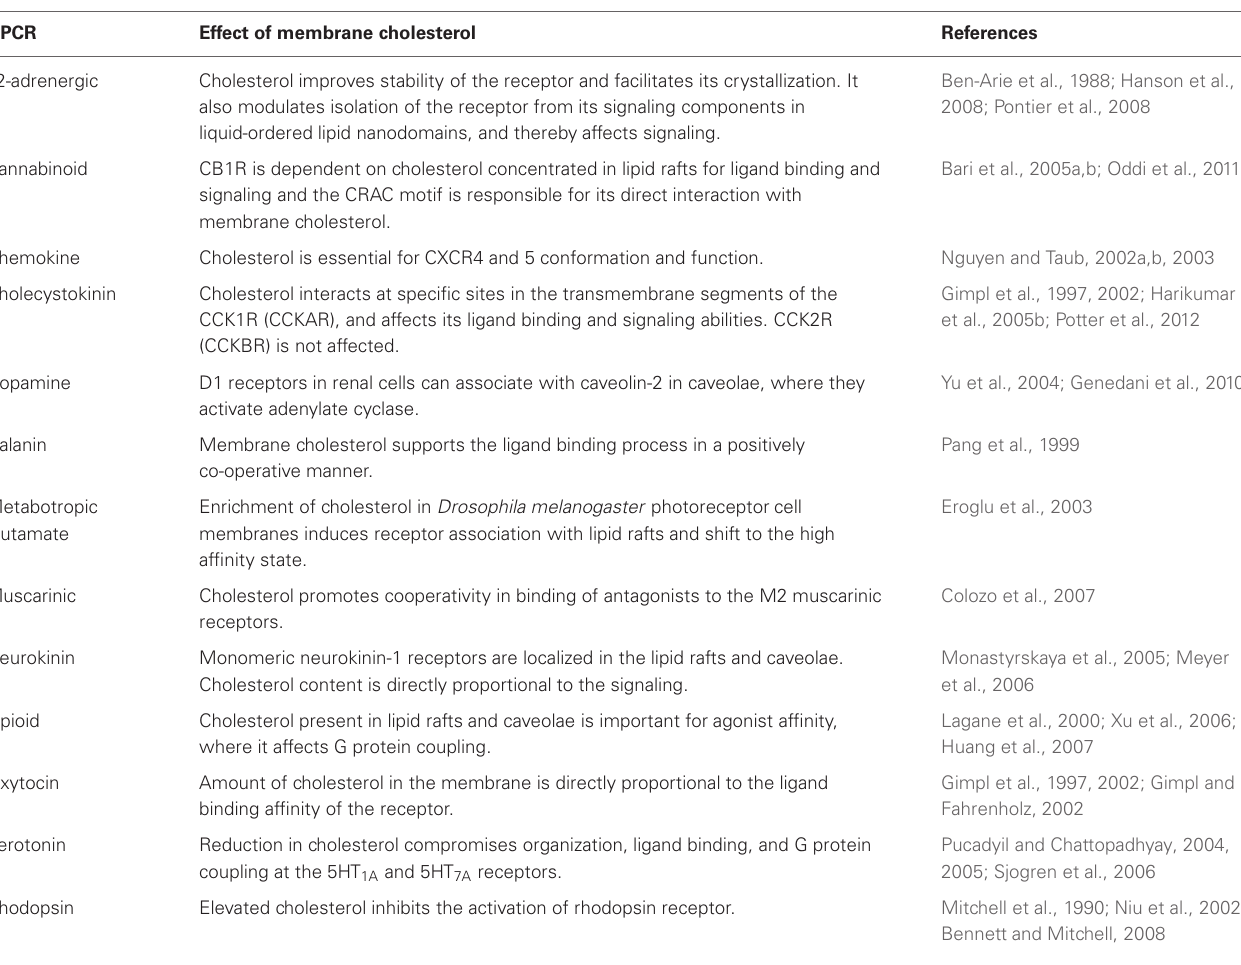
Table 1 | List of GPCRs affected by membrane